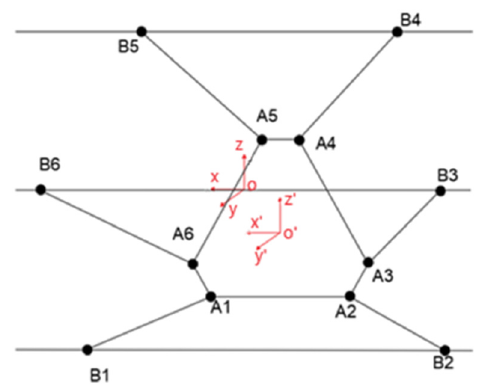
Figure 6. Schematic diagram of the mechanism.